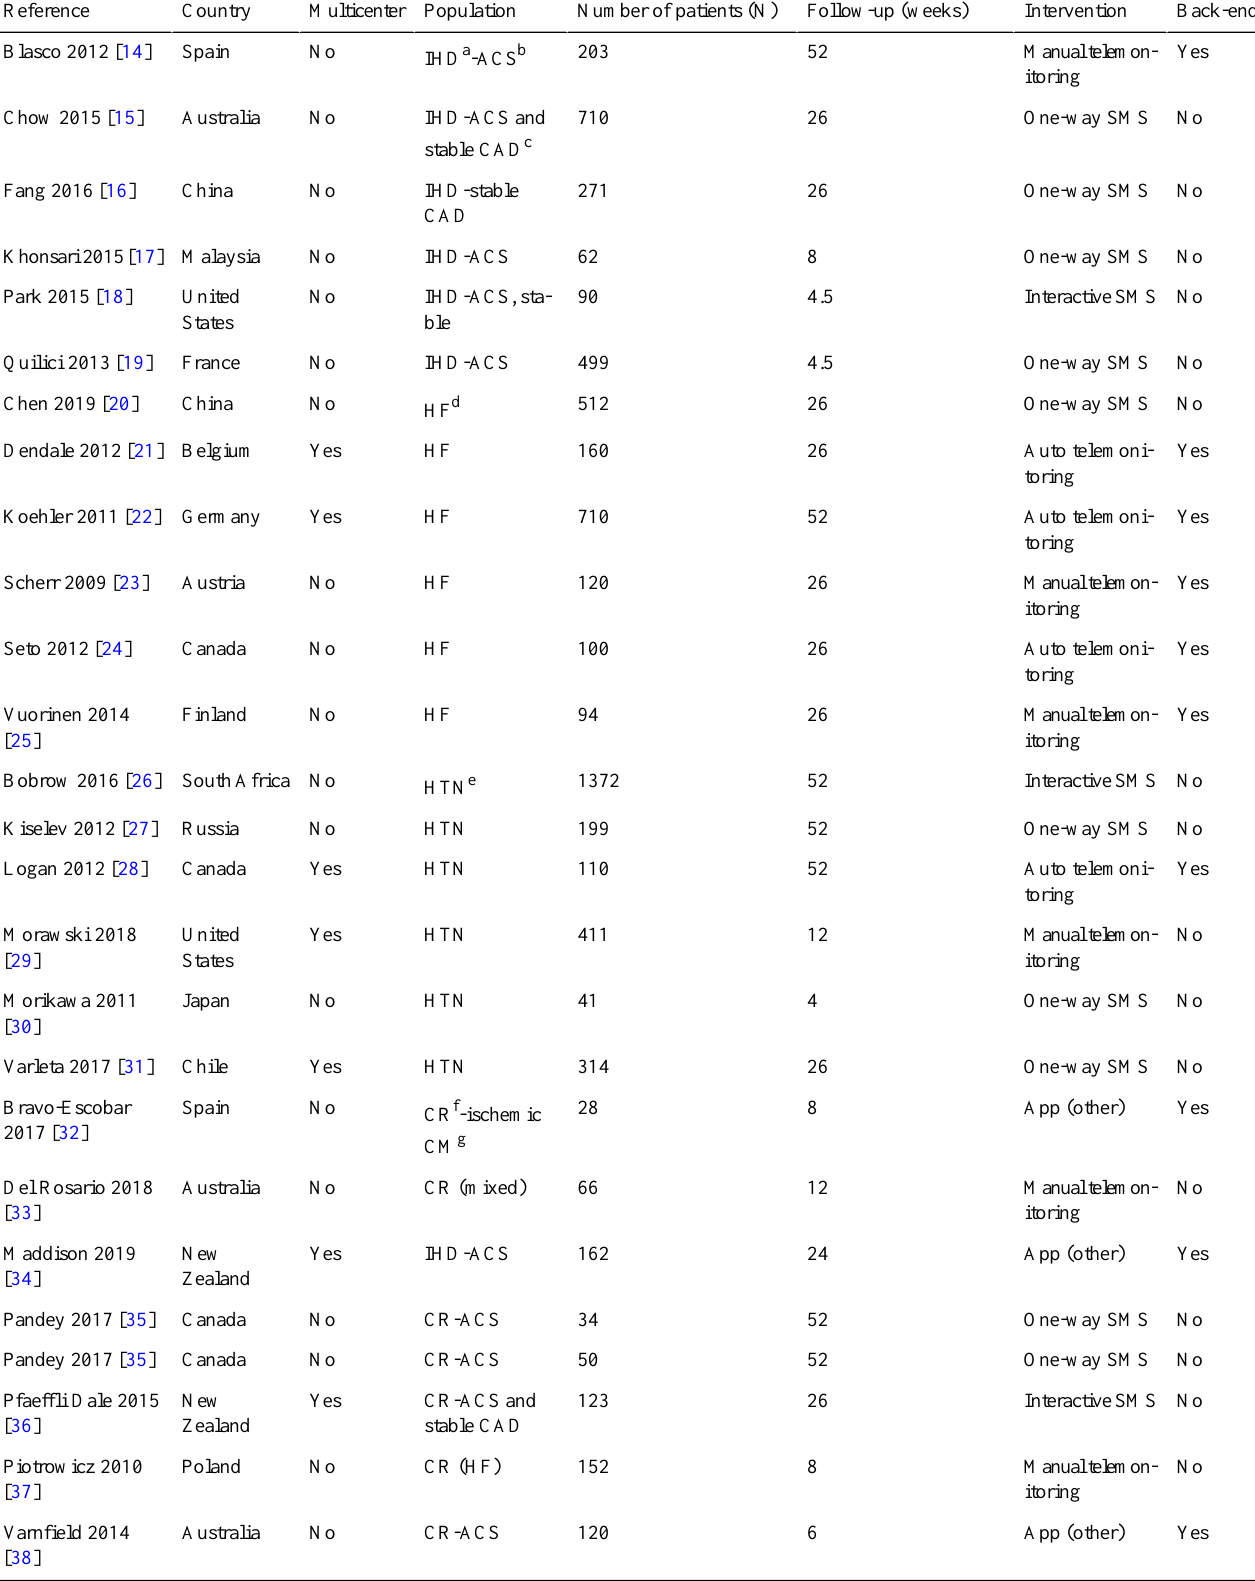
Table 1. Characteristics of the studies included in the systematic